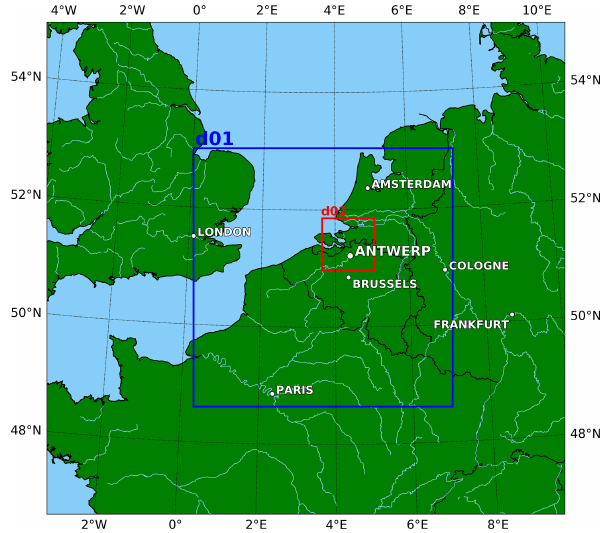
Figure 1. Map of western Europe, indicating the two model do- mains in blue (d01; 5 × 5km 2 resolution) and red (d02; 1 × 1km 2